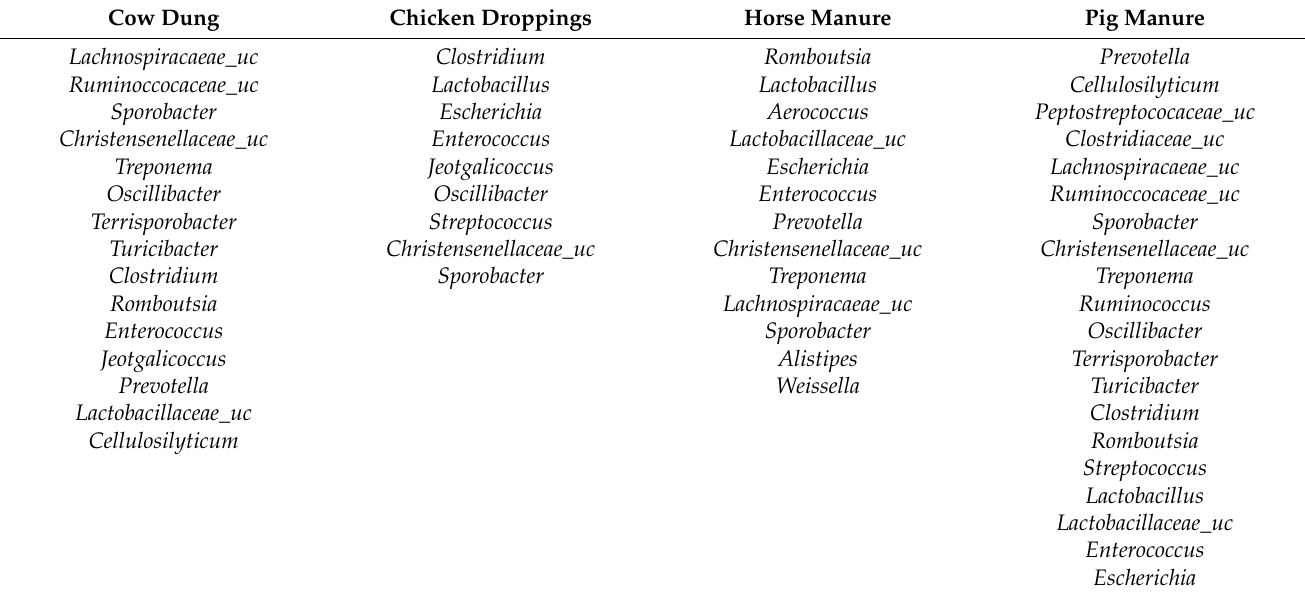
Table A4. Bacterial genera relevant for biogas